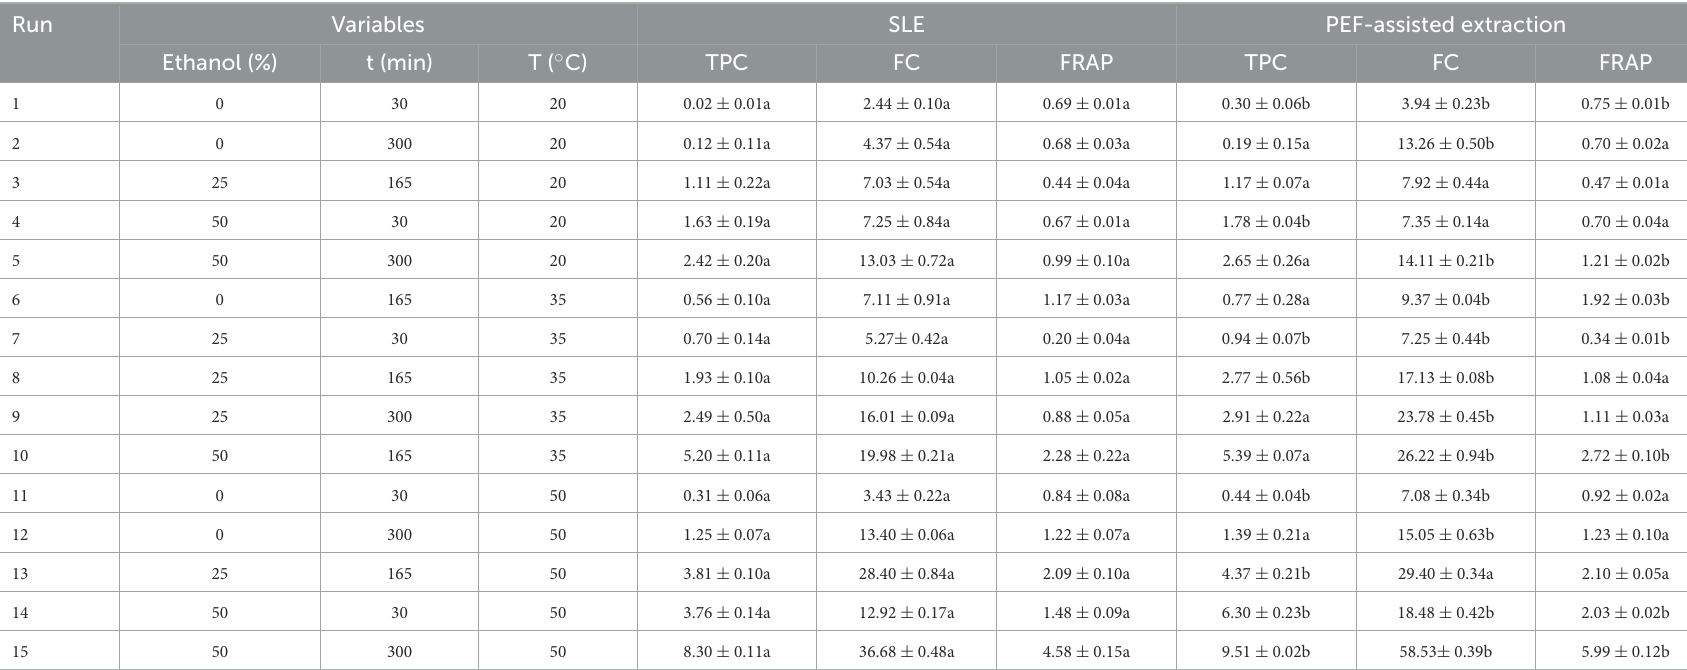
TPCisexpressedinmgGAE/g DM grapepomace,FCisexpressedinmgQE/g DM grapepomaceandFRAPinmgAAE/g DM grapepomace.Theresultsareexpressedasmean ± standard deviation(n = 2forfactorialandaxialpoints,n = 5forcentralpoint).Ethanol, meansethanolpercentageinethanol-watermixture(%,v/v);t,extractiontime(min)T,extractiontemperature( ◦ C).Valuesofthesamedependentvariablewithdifferentlowercaseletterwithinthesamerowaresignificantlydifferent(p ≤